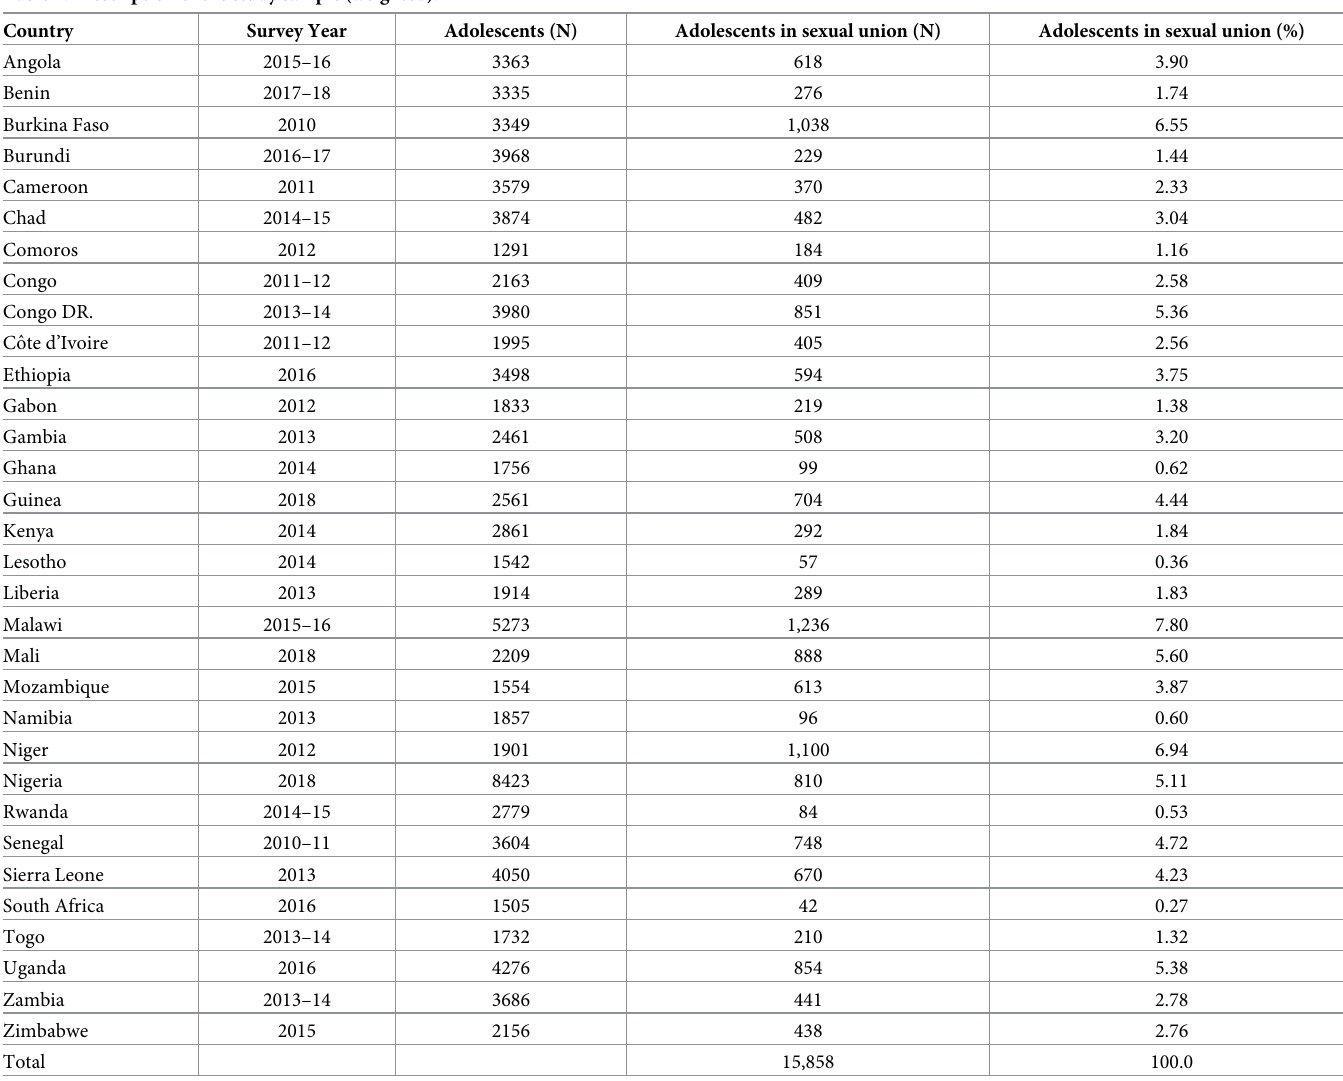
Table 1. Description of the study sample